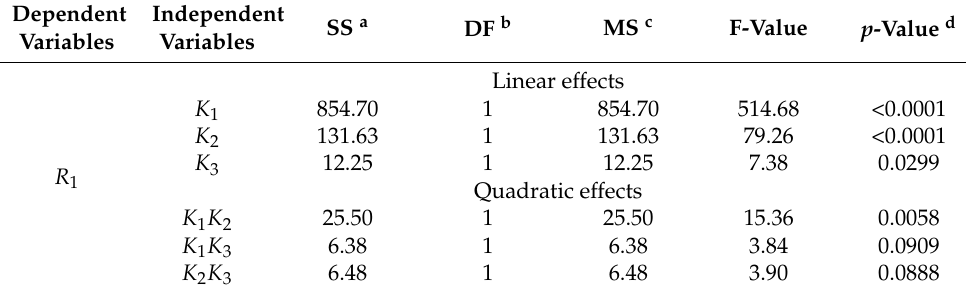
Table 5. Significance of each response variable effect shown by using the F ratio and p -value in the near second-order